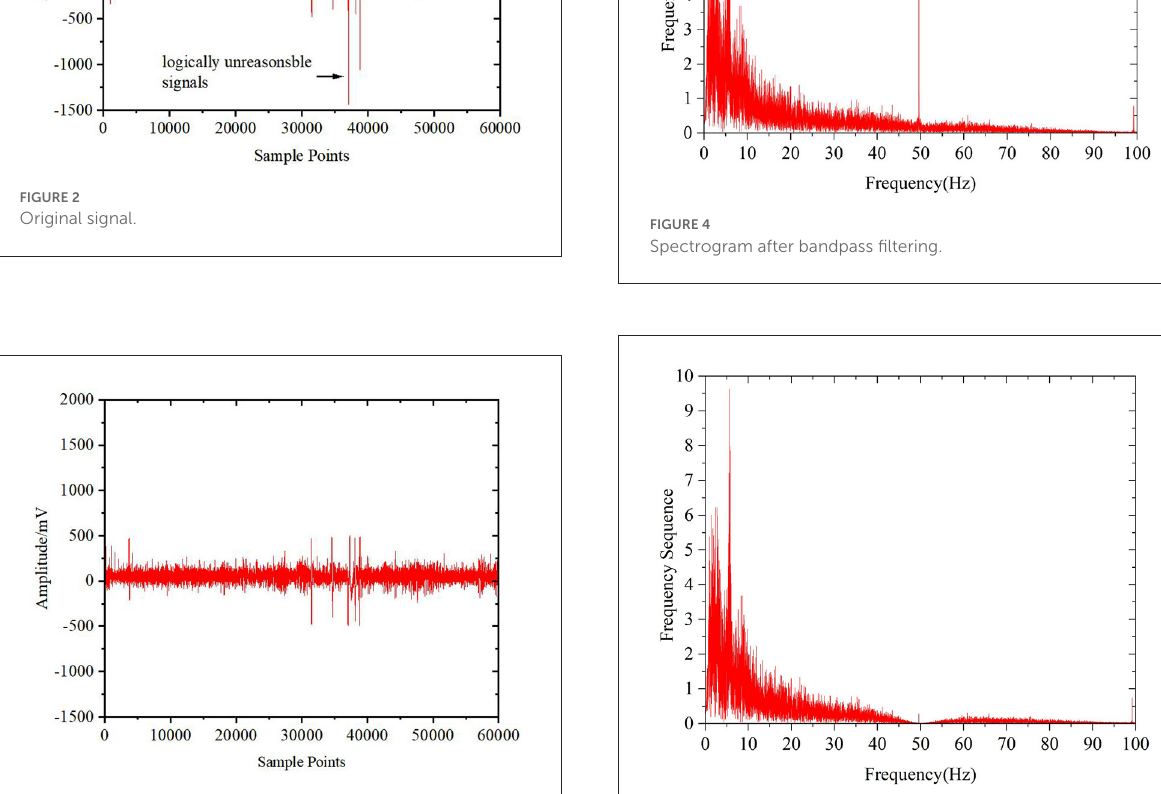
FIGURE3 Signal after consistency check and interpolation.